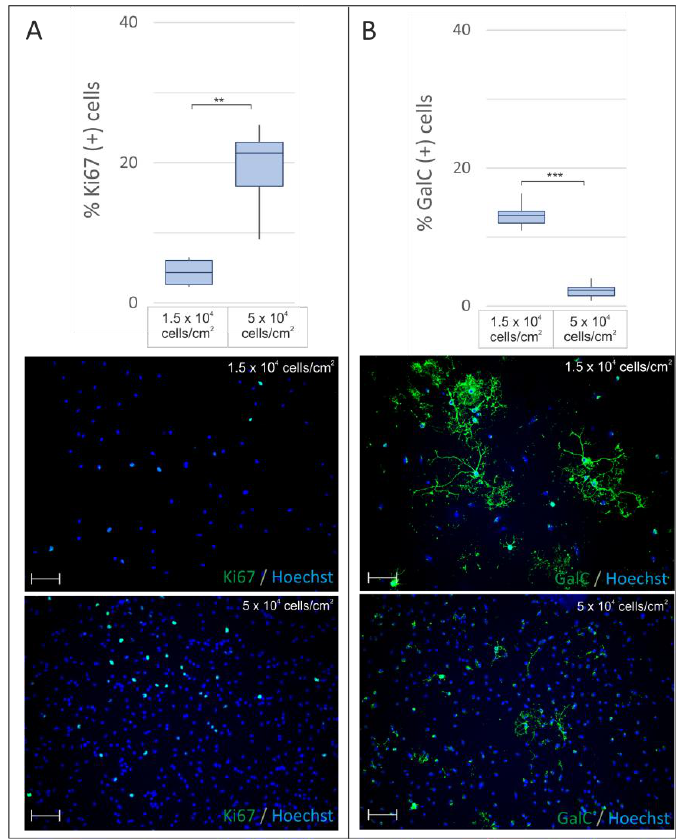
Figure 2. The influence of the cell seeding density on OPC proliferation (revealed by Ki67 immunostaining, green ) and differentiation (estimated by GalC expression, green ) determined